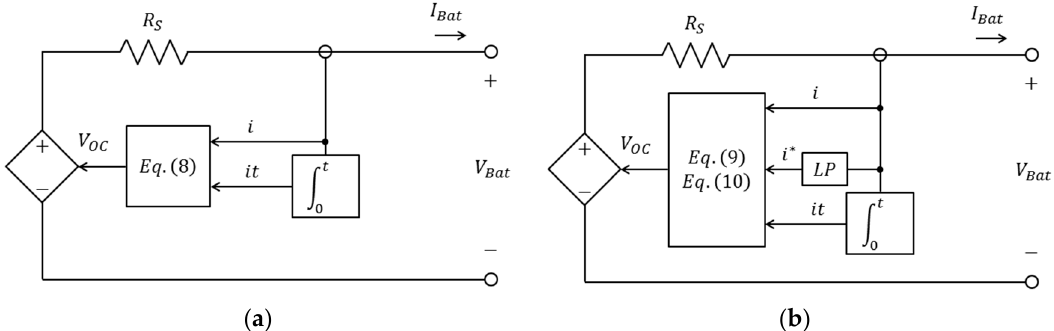
Figure 5. ( a ) Original Shepherd’s model. ( b ) Modified Shepherd’s model .